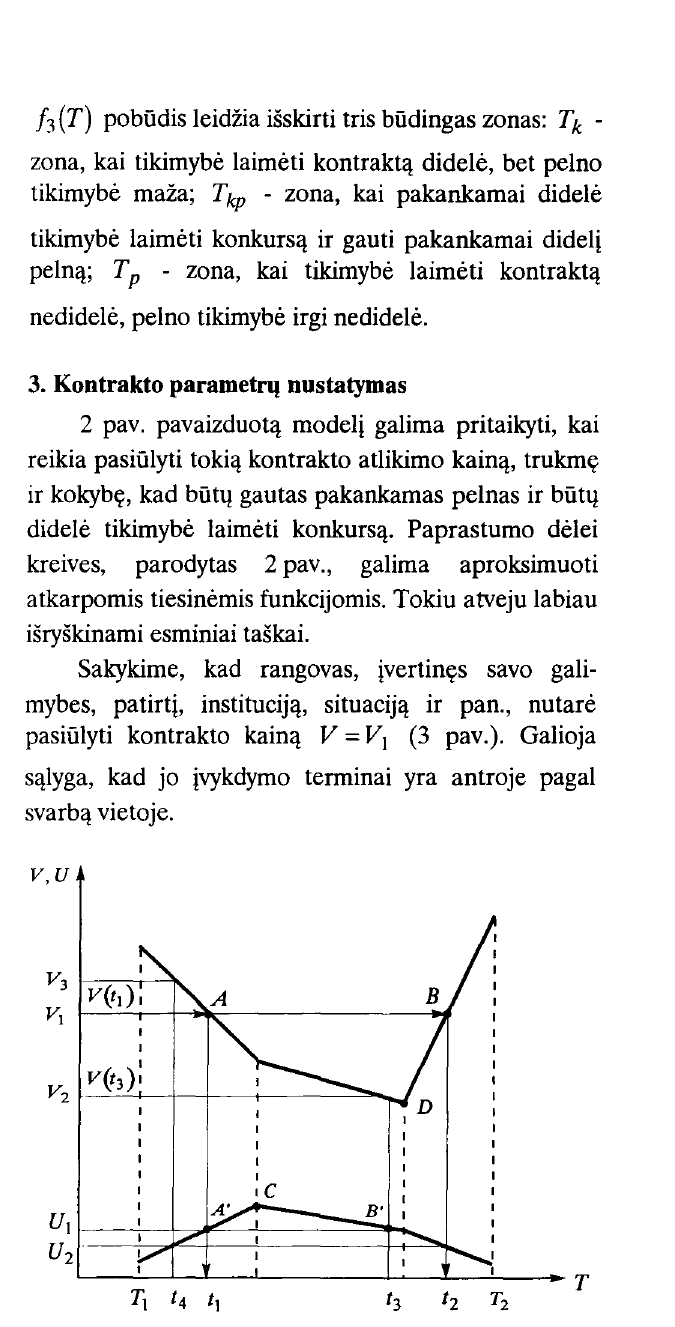
Fig 3. Dependency of contract price and profit on time, = when V V 1 Tokiu 1 , f(T) ir